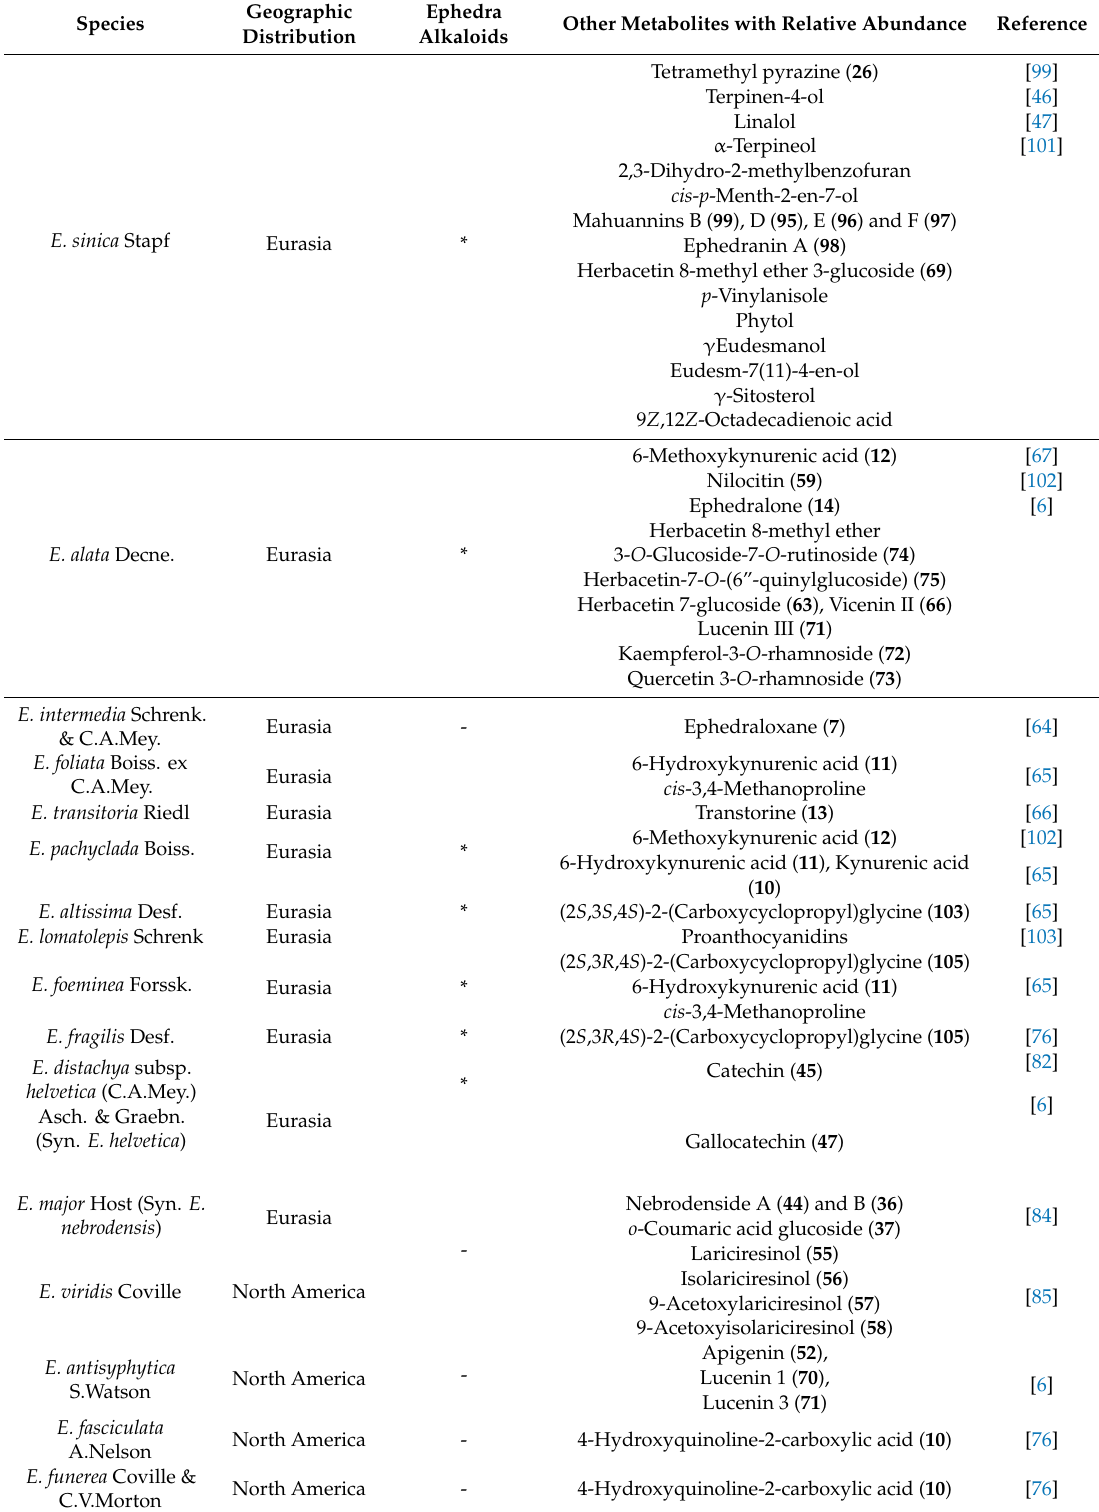
Table 3. Geographicaldistributionof Ephedra species, presenceof Ephedra alkaloidsandothermetabolites.